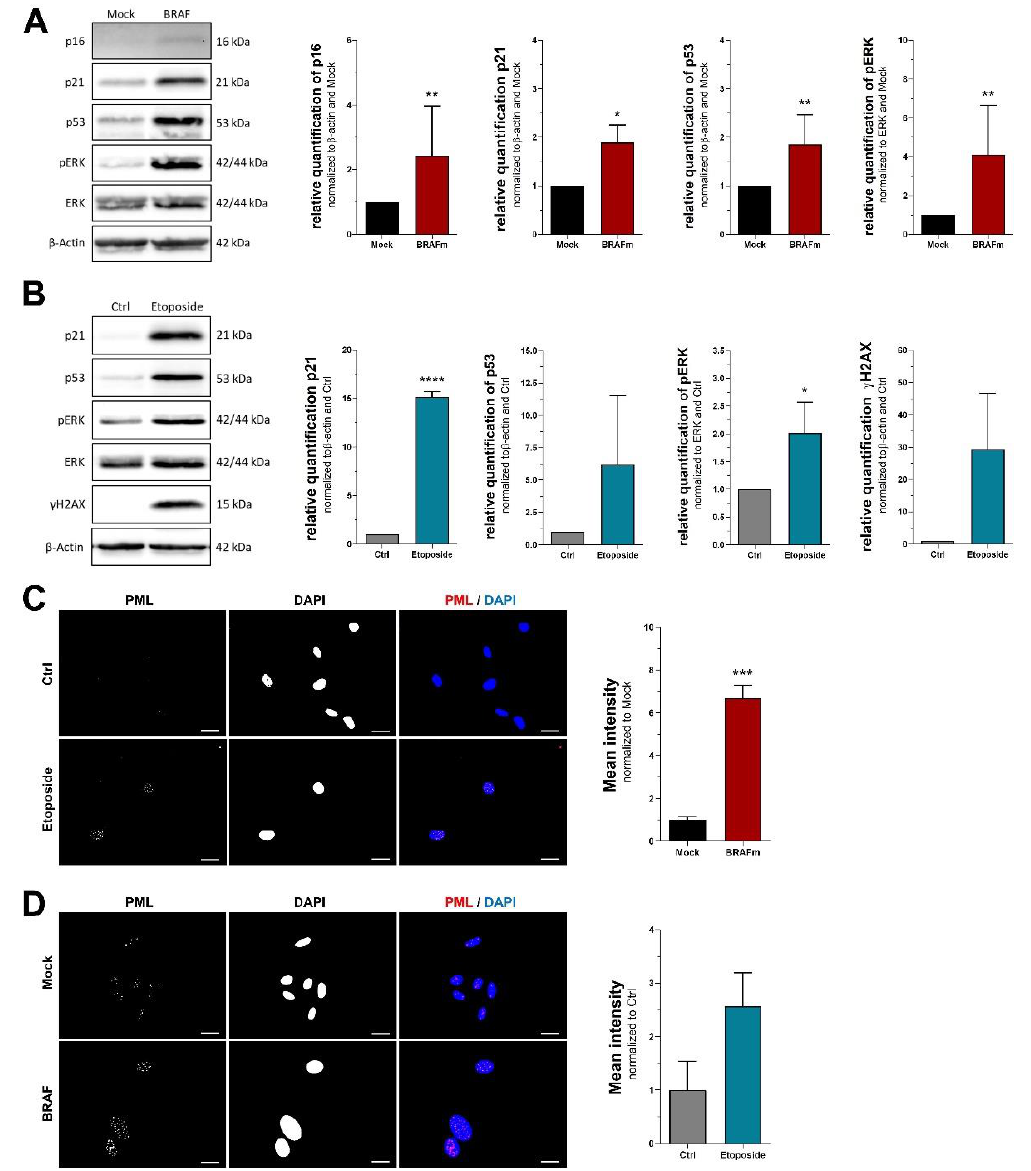
Figure 2. Protein markers of cellular senescence. Western blot analysis of ( A ) NHEM transduced with mutated BRAF V600E (all n = 7, p16 n = 6) and ( B ) melanoma cell line Mel Juso treated with 100 µM etoposide (n = 3). ( C , D ) Immunofluorescent stainings of PML and DAPI. Scale bars equal 20 µm. Bars are shown as mean ± SEM (Student’s t -test). (*: p < 0.05, **: p < 0.01, ***: p < 0.001, ****: p < 0.0001).